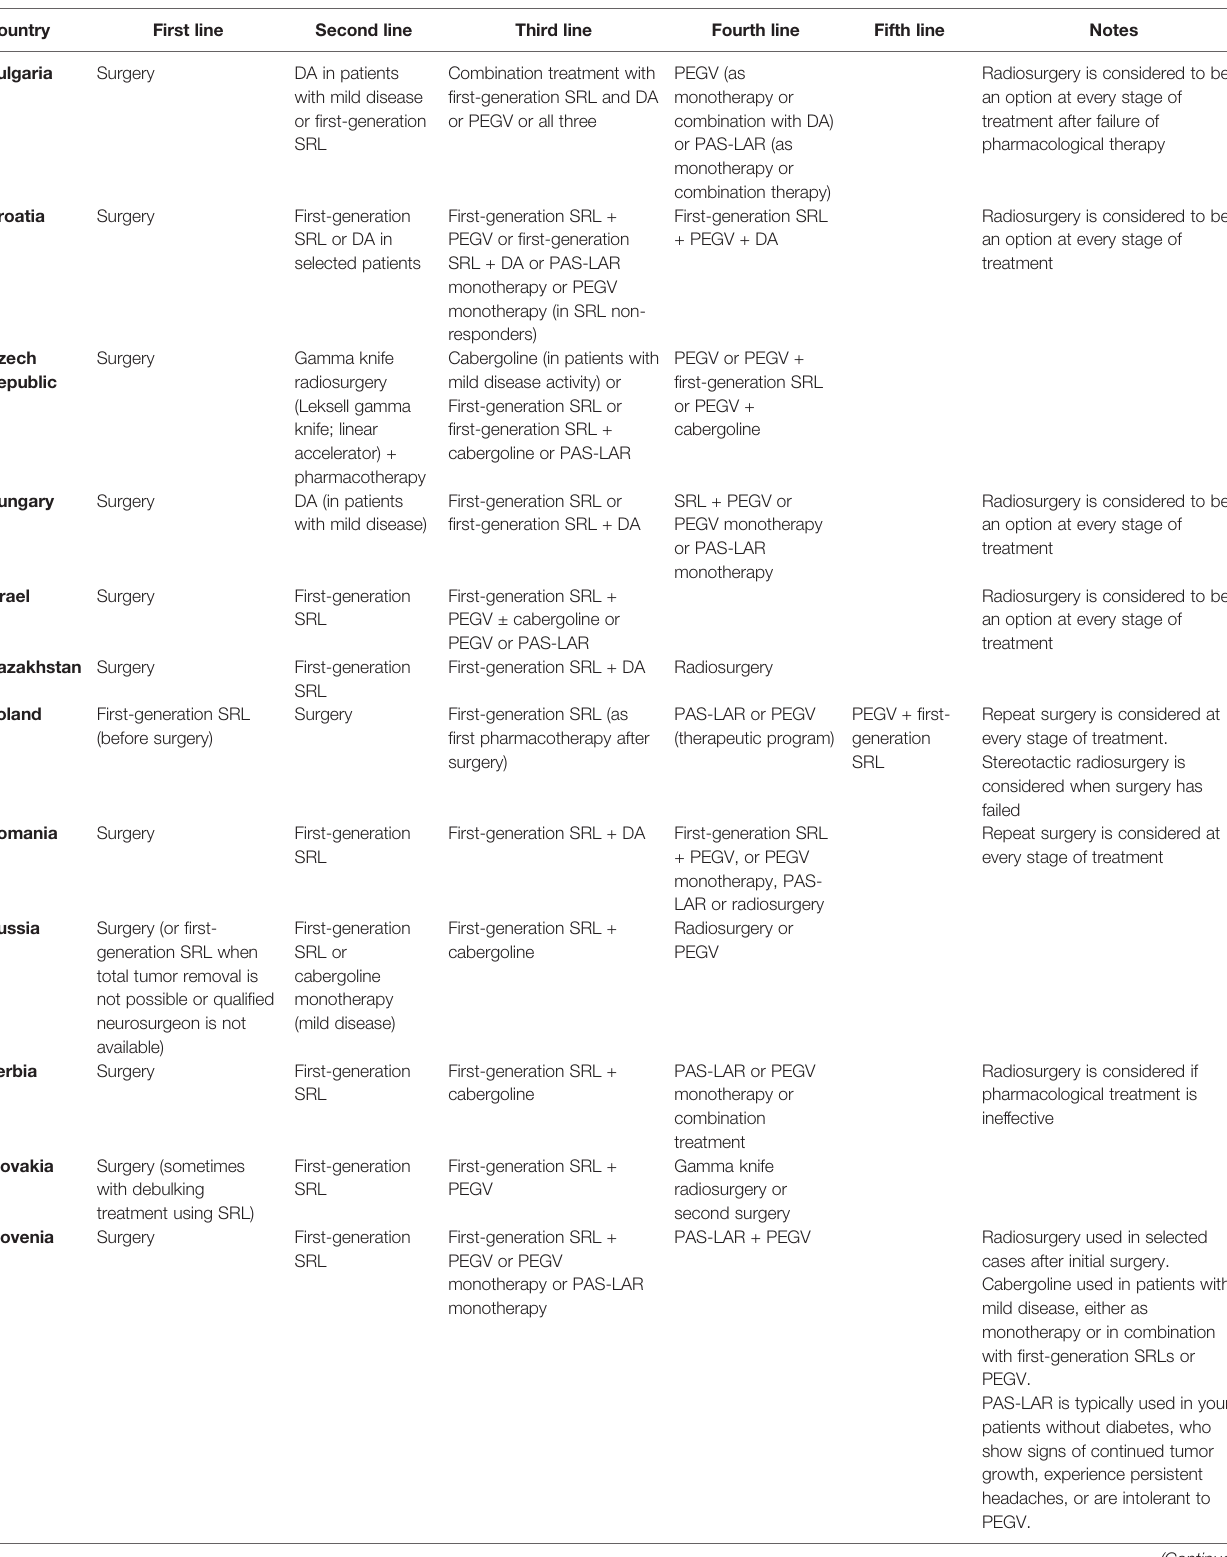
TABLE 2 | Different treatment modalities according to the panel experts from CEE, Israel, and Kazakhstan.